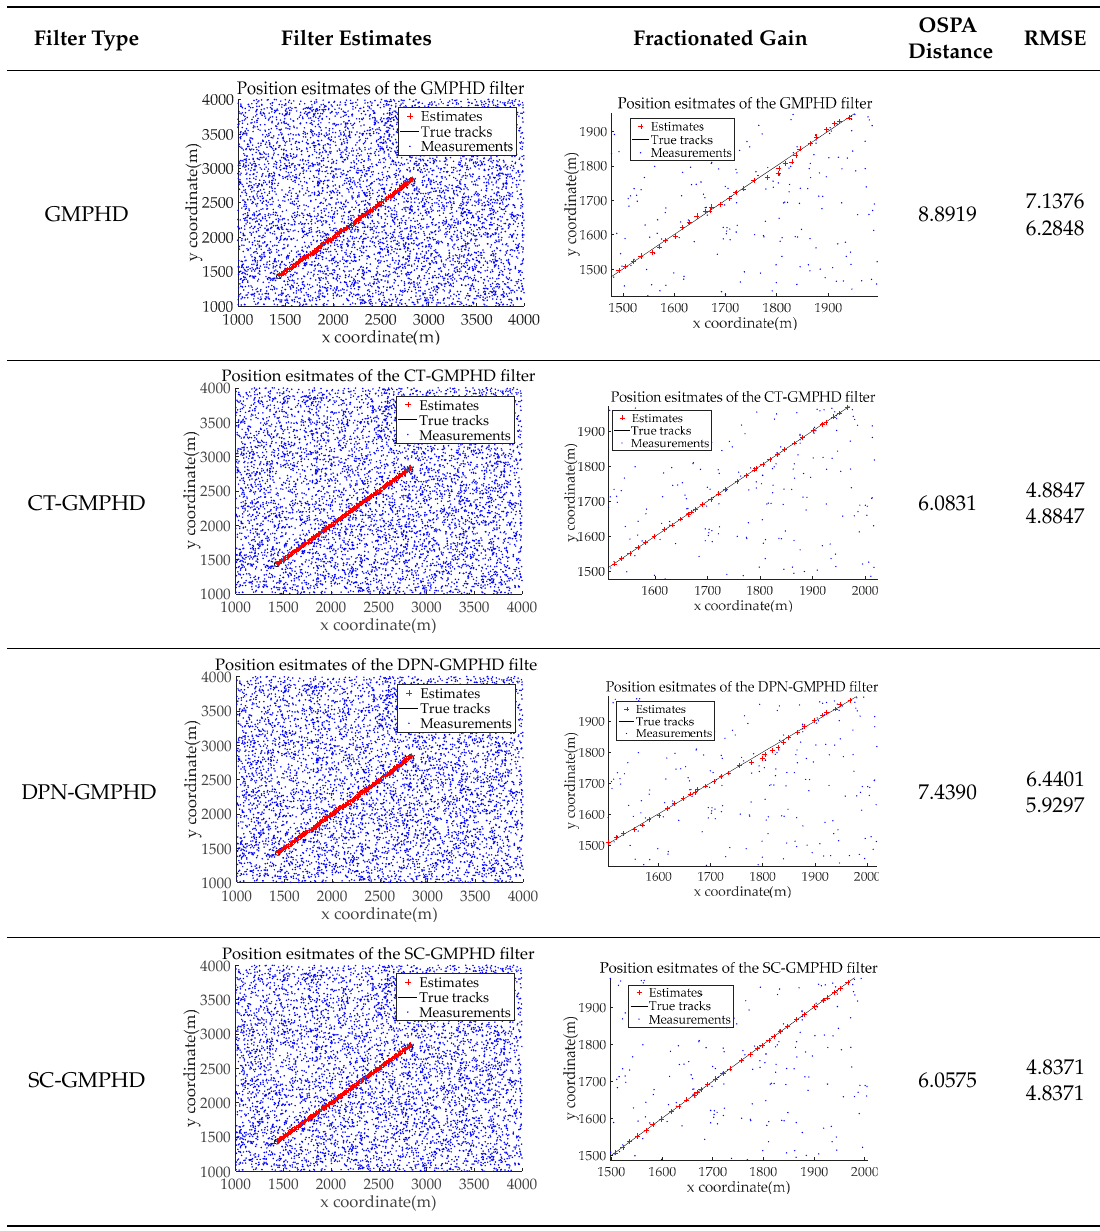
Table 1. Filtering performance comparison of four filters.